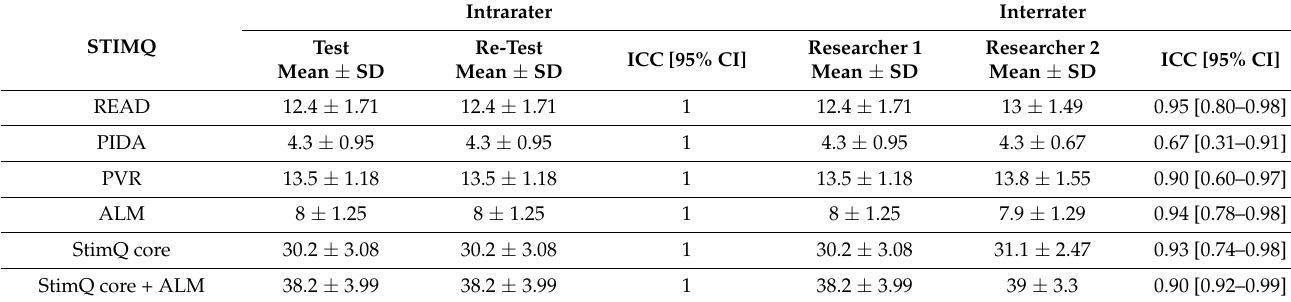
Table 6. Interrater and intrarater reliability scores for toddlers.